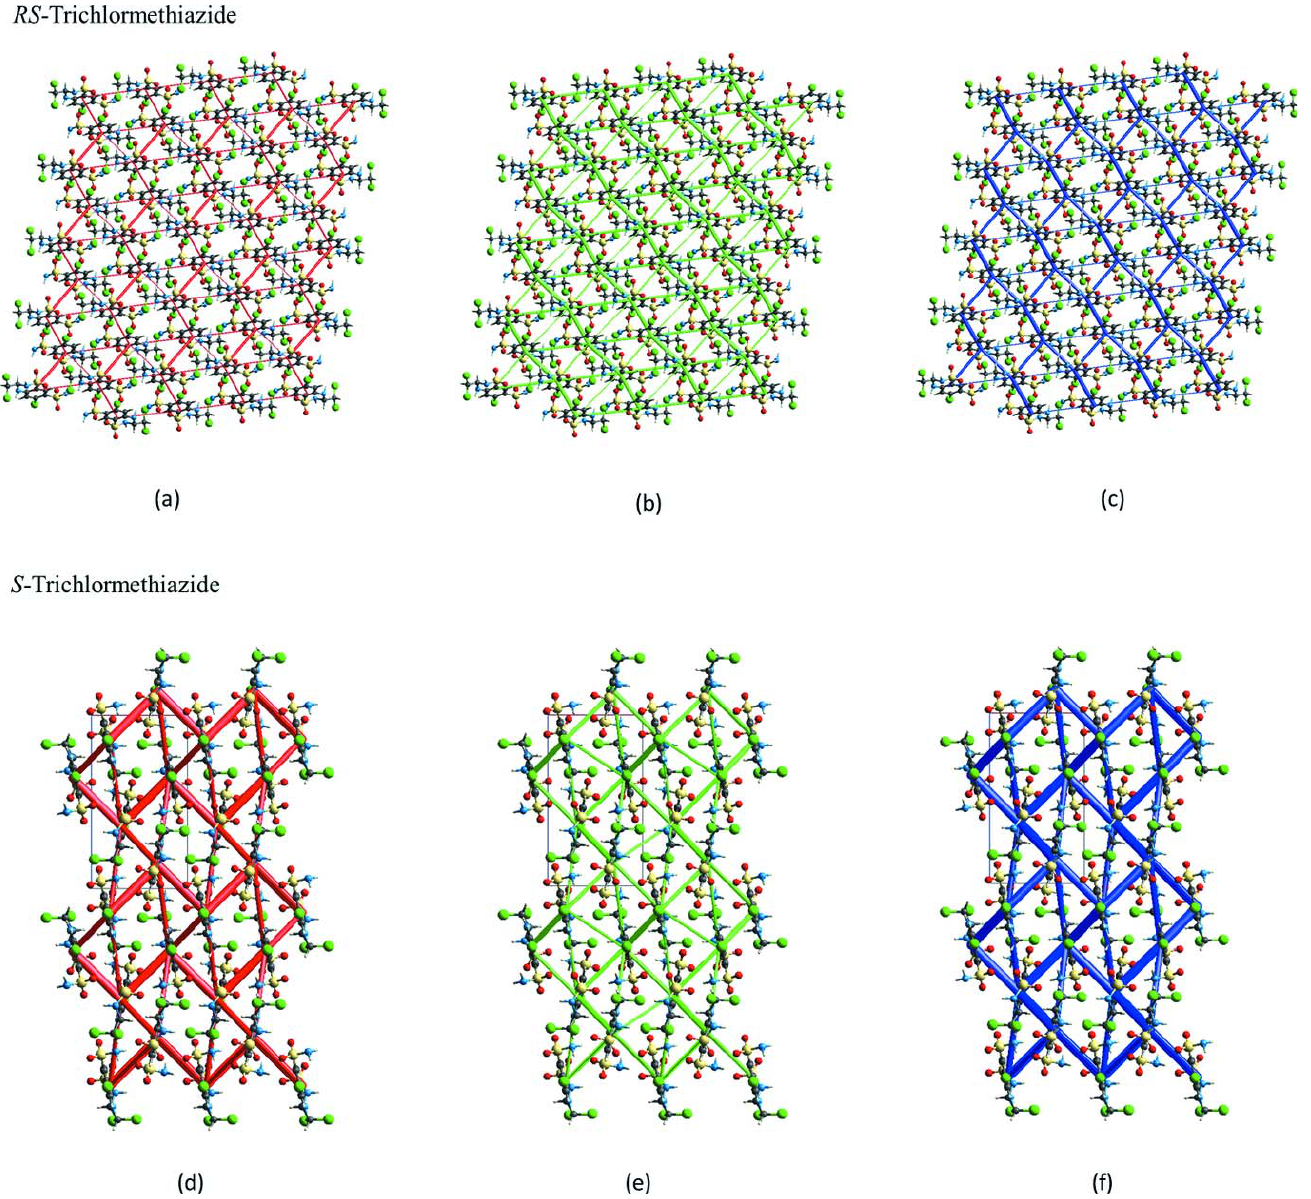
Figure 9 Energy frameworks calculated for RS -TCMZ viewed down the b -axis: ( a ) E ele , red; ( b ) E dis , green; ( c ) E tot , blue. Energy contributions are represented within 4 (cid:6) 4 (cid:6) 4 unit cells. The cylinder radii were scaled to 50 arbitrary units with a cut-off value of 10 kJ mol (cid:5) 1 . Energy frameworks calculated for S - TCMZ viewed down the b -axis represented within 2 (cid:6) 2 (cid:6) 2 unit cells: ( d ) E ele , red; ( e ) E dis , green; and ( f ) E t ot , blue. The cylinder radii were scaled to 80 arbitrary units with a cut-off value of 5 kJ mol (cid:5) 1